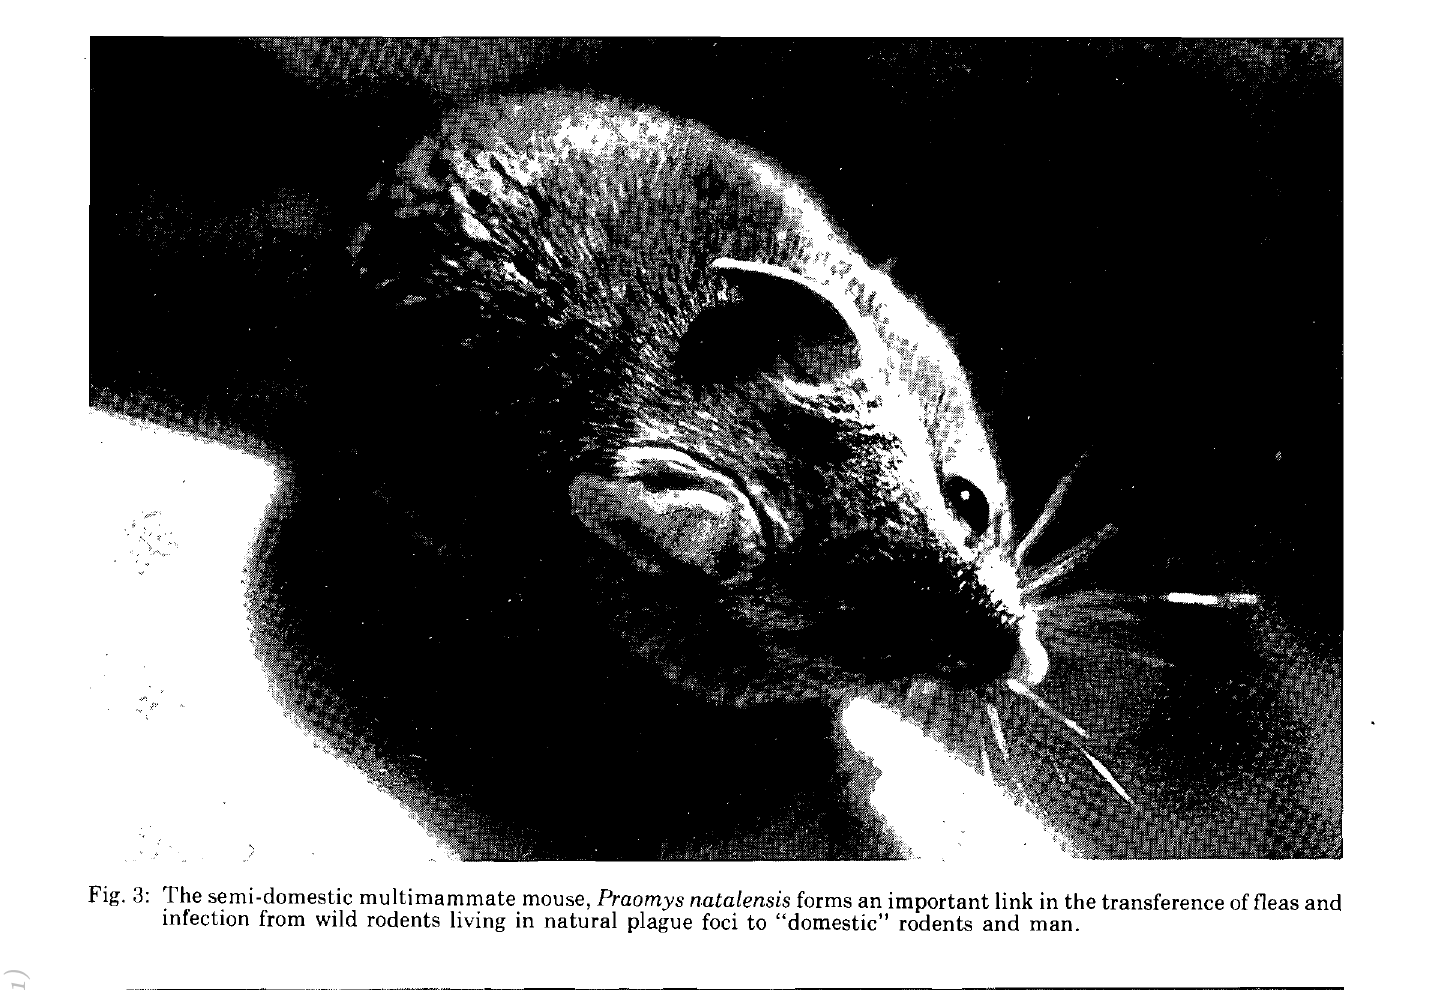
Fig. 3: The semi-domestic multimammate mouse, Praomys natalensis forms an important link in the transference of fleas and infection from wild rodents living in natural plague foci to "domestic" rodents and man.